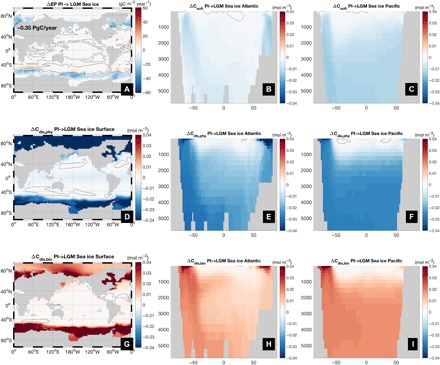
Effect of sea ice changes on carbon storage.Change in (A) EP, (B and C) Csoft, (D to F) Cdis,phy, and (G to I) Cdis,bio due to expanded sea ice cover. Black solid line is the zero contour.